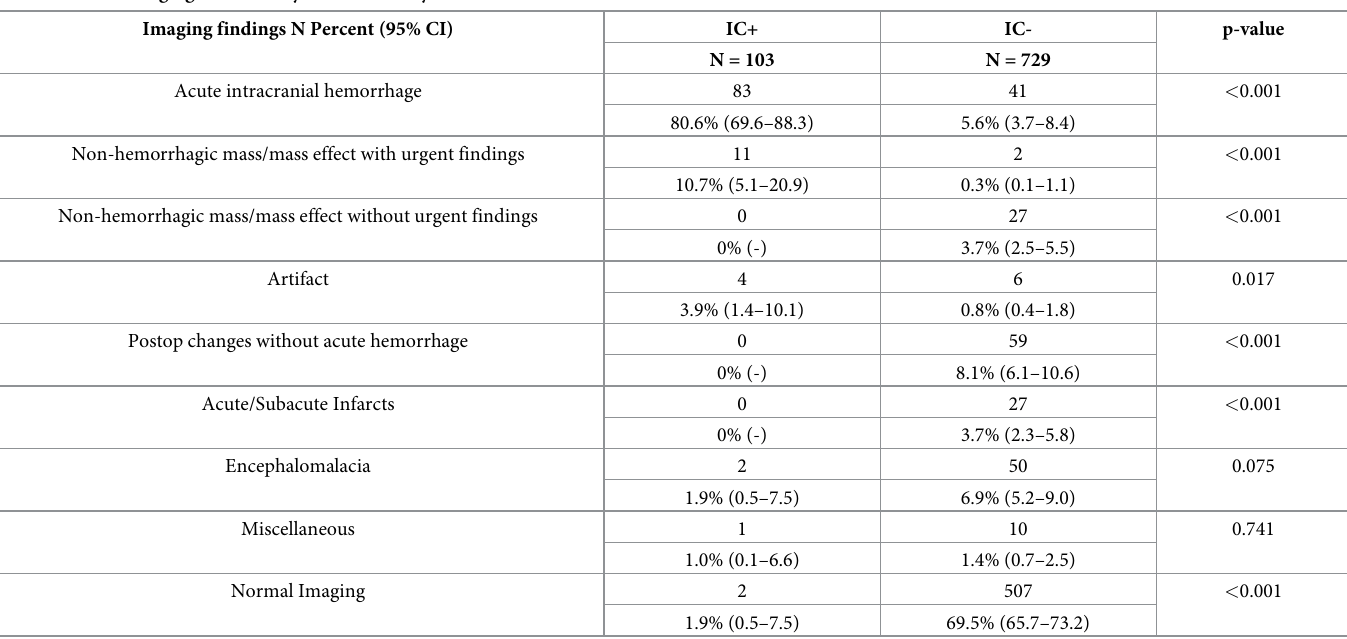
Table 1. Neuroimaging abnormality distribution by classification. Imaging findings N Percent (95%